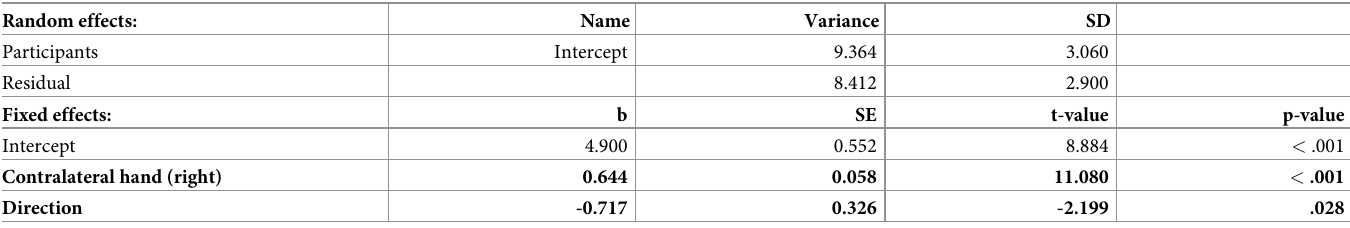
Table 9. Model 2.3. Effect of Direction on the left grip force (after controlling for the contralateral force) in the time window 100–150 ms (Experiment 2). Random